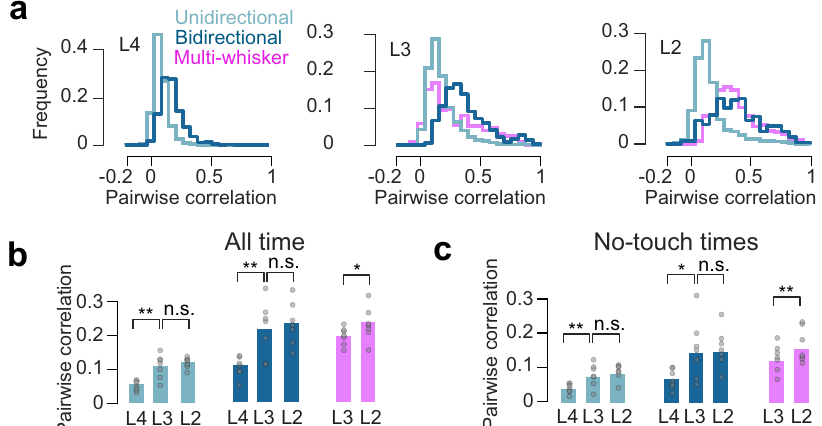
Fig. 6 | Pairwise correlations across layers and neuron types. a Distribution of pairwise correlations for different touch types for an example animal, computed over all imaging time. b Average pairwise correlations for speci fi c neuronal types, layers. Correlations were computed using all available imaging time. Bars, mean